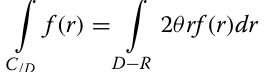
geometry perspective, taking into account the inter cell interference.